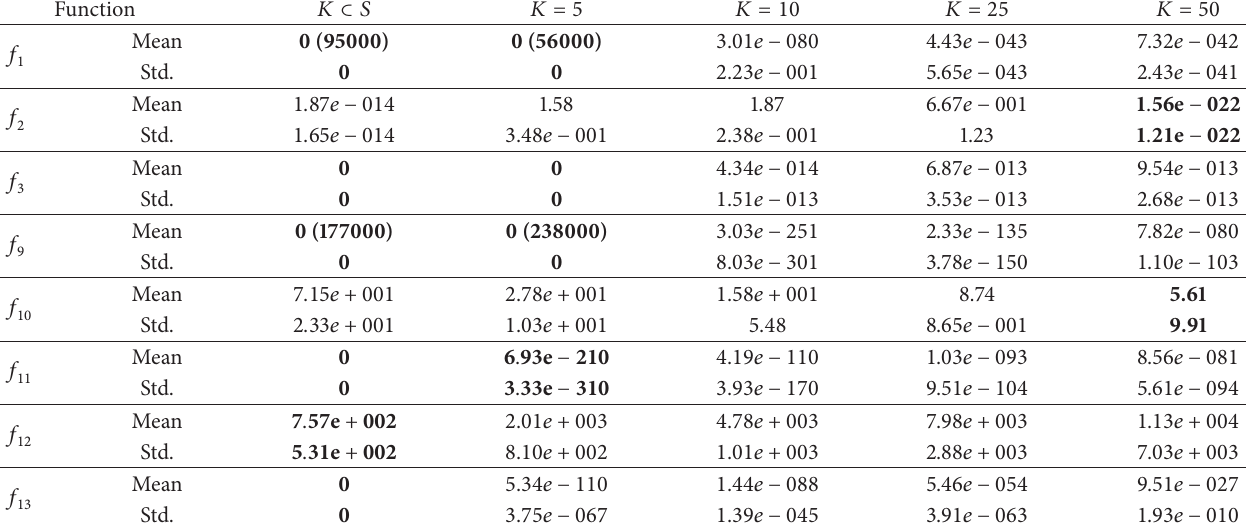
– f & f – f ) with the different grouping number 𝐾 . In bold are the best 1 3 9 13